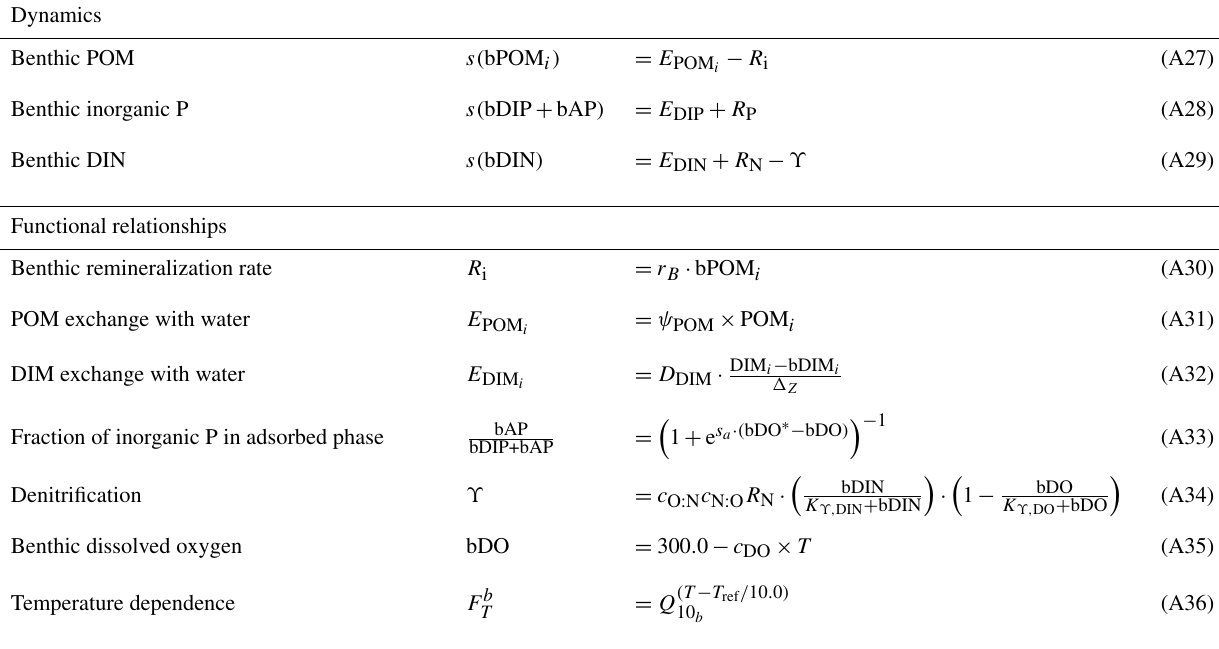
Table A4. Source–sink terms of the dynamic variables and functional relationships of the benthic module. For POM i and DIM i , i = N , P. Description of parameters are provided in Table A5.